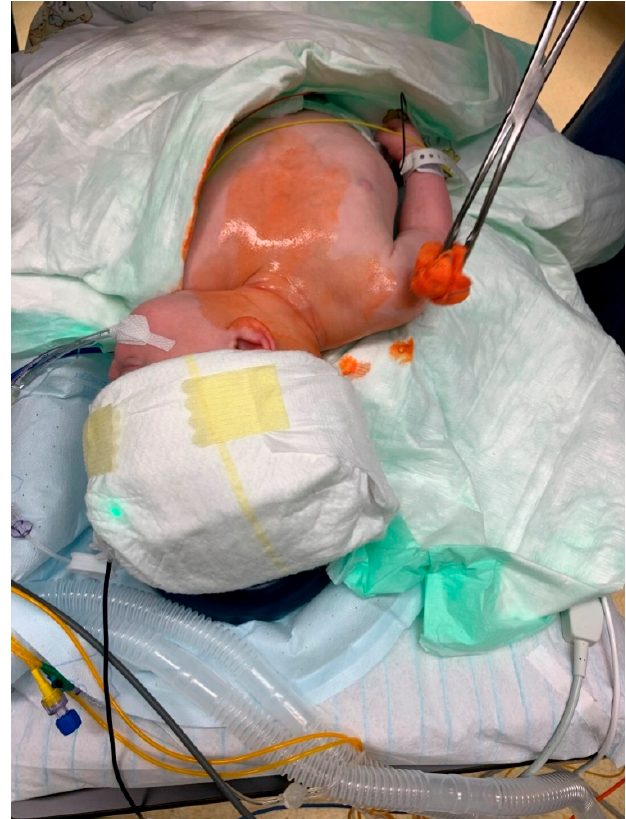
Figure 5. Insulation of the body parts (e.g., napkin for the head) that cannot be actively warmed to reduce heat losses during washing and draping of an infant.